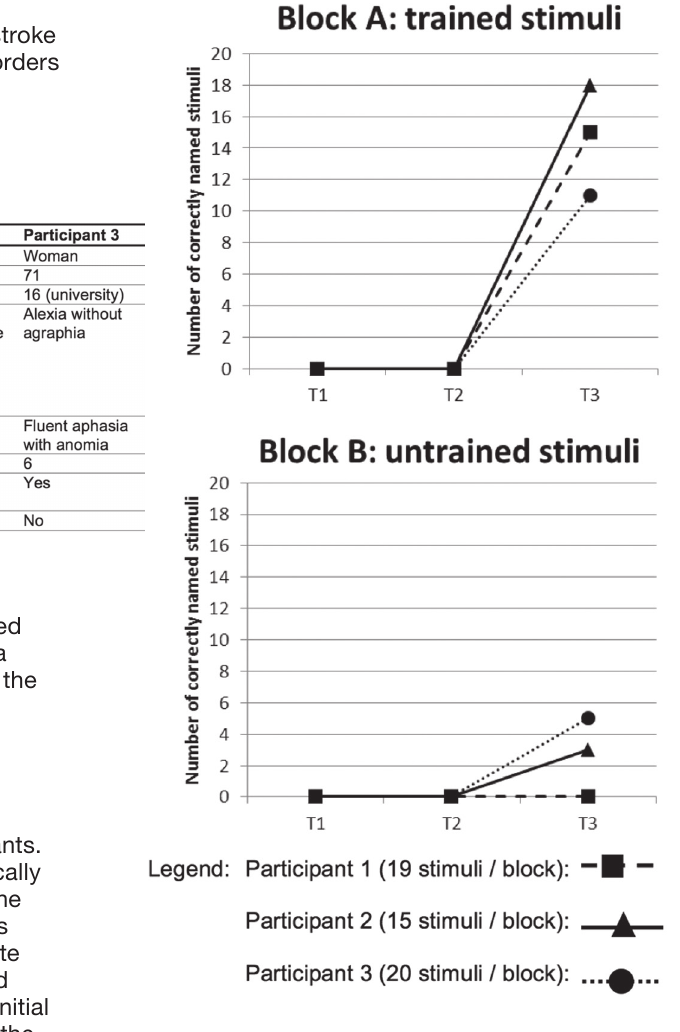
Figure 3: Confrontation naming (Block A and Block B) at T1, T2 and